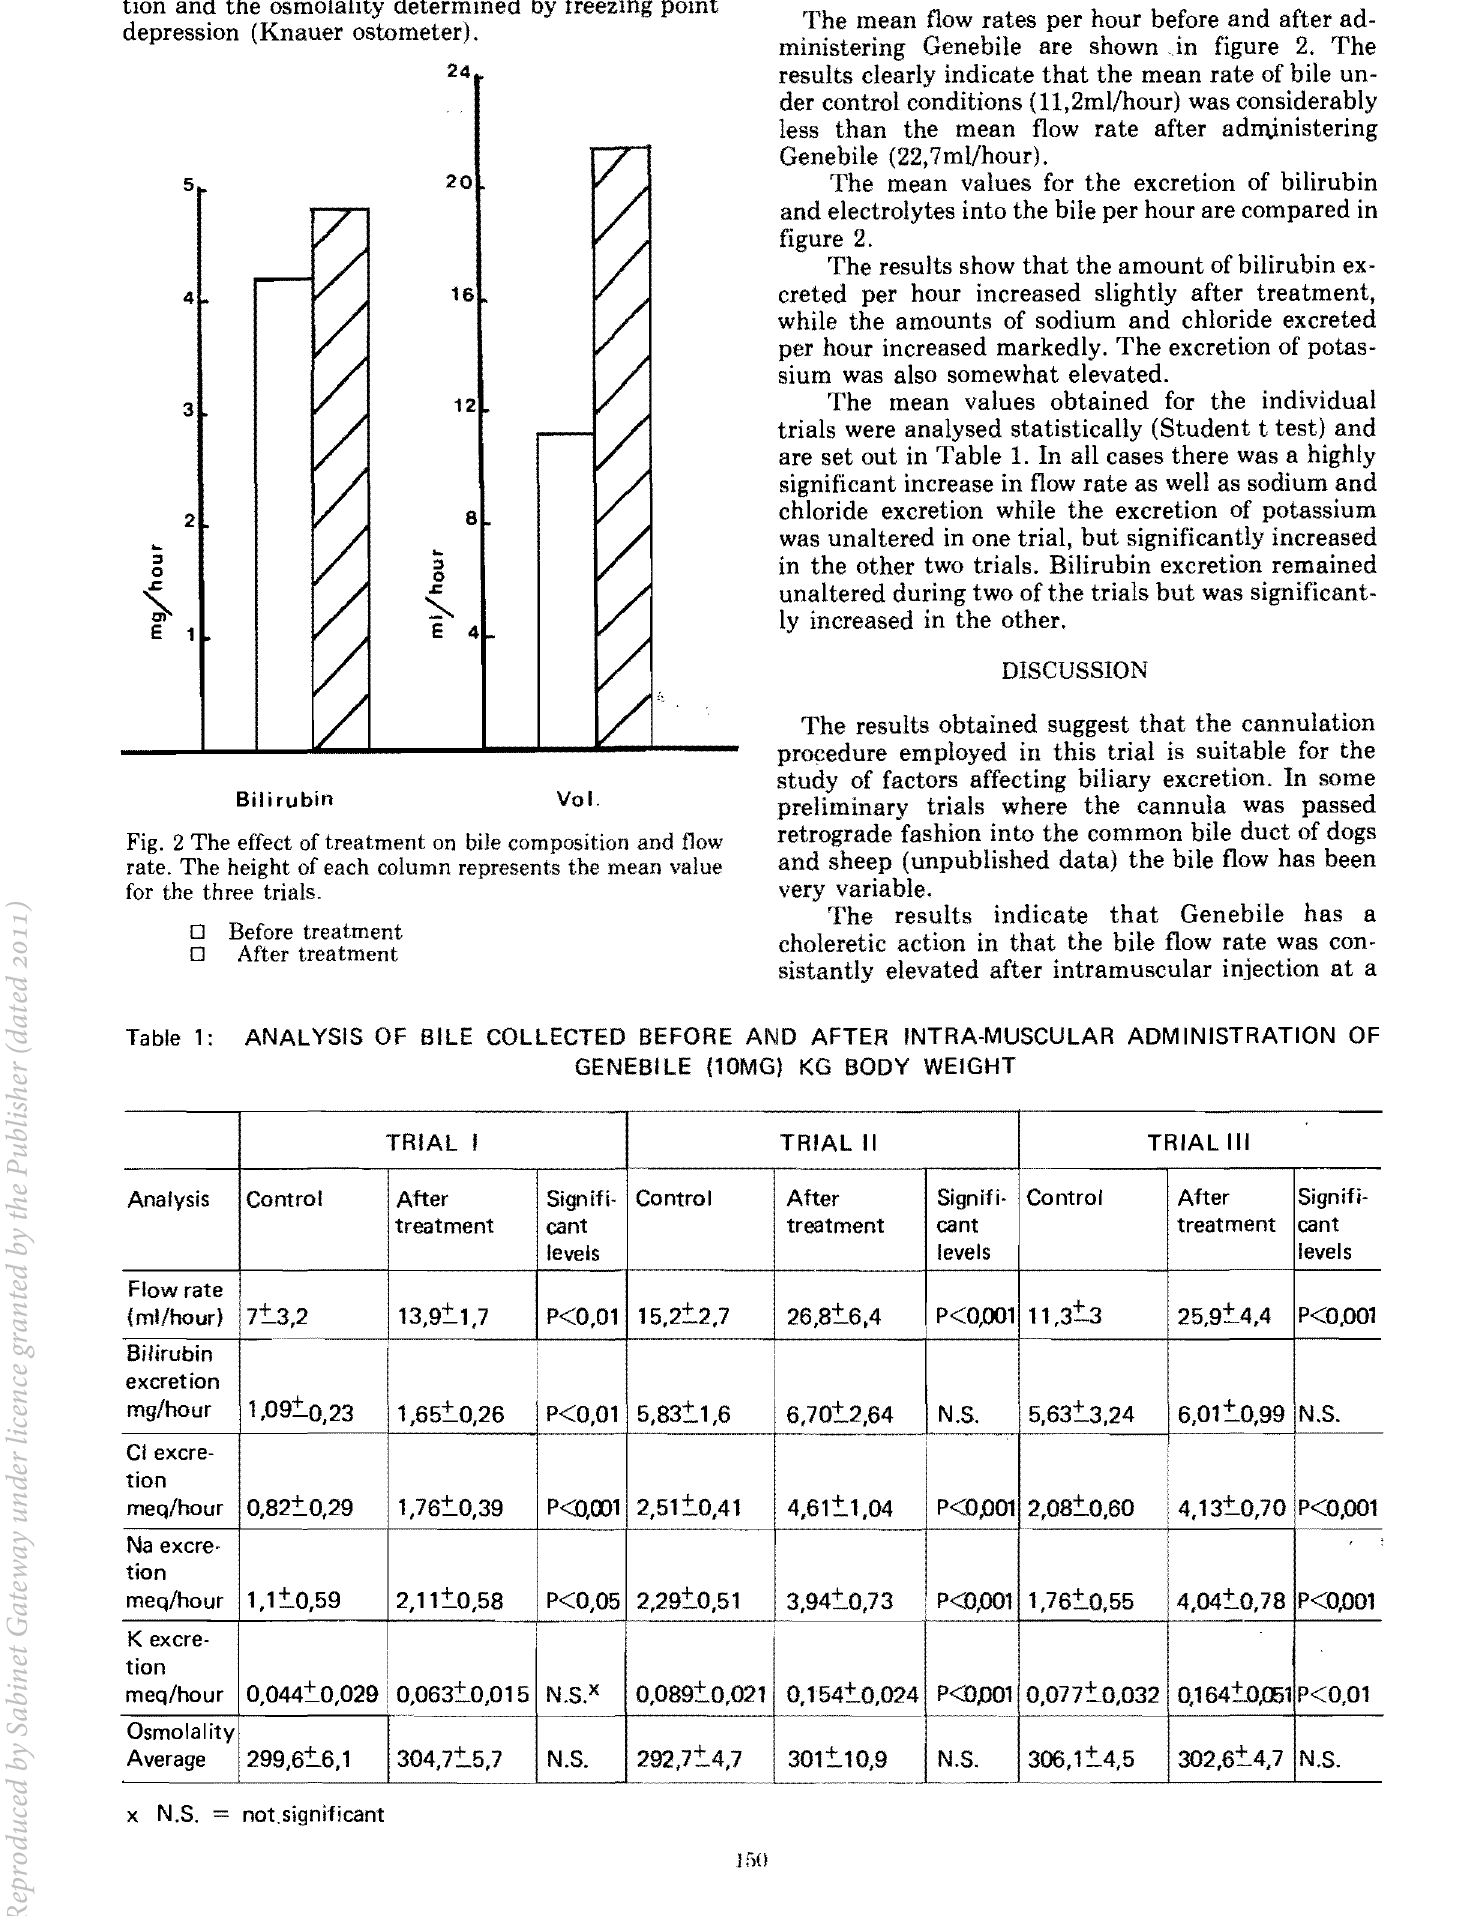
Table 1 : ANALYSIS OF BILE COLLECTED BEFORE AND AFTER INTRA-MUSCULAR ADM INISTRATION OF GENEBILE (10MG) KG BODY WEIGHT TRIAL I TRIAL II TRIAL III Analysis Control After Signifi- Control After Signifi. Control After Signifi- treatment cant treatment cant treatment cant levels levels levels Flow rate